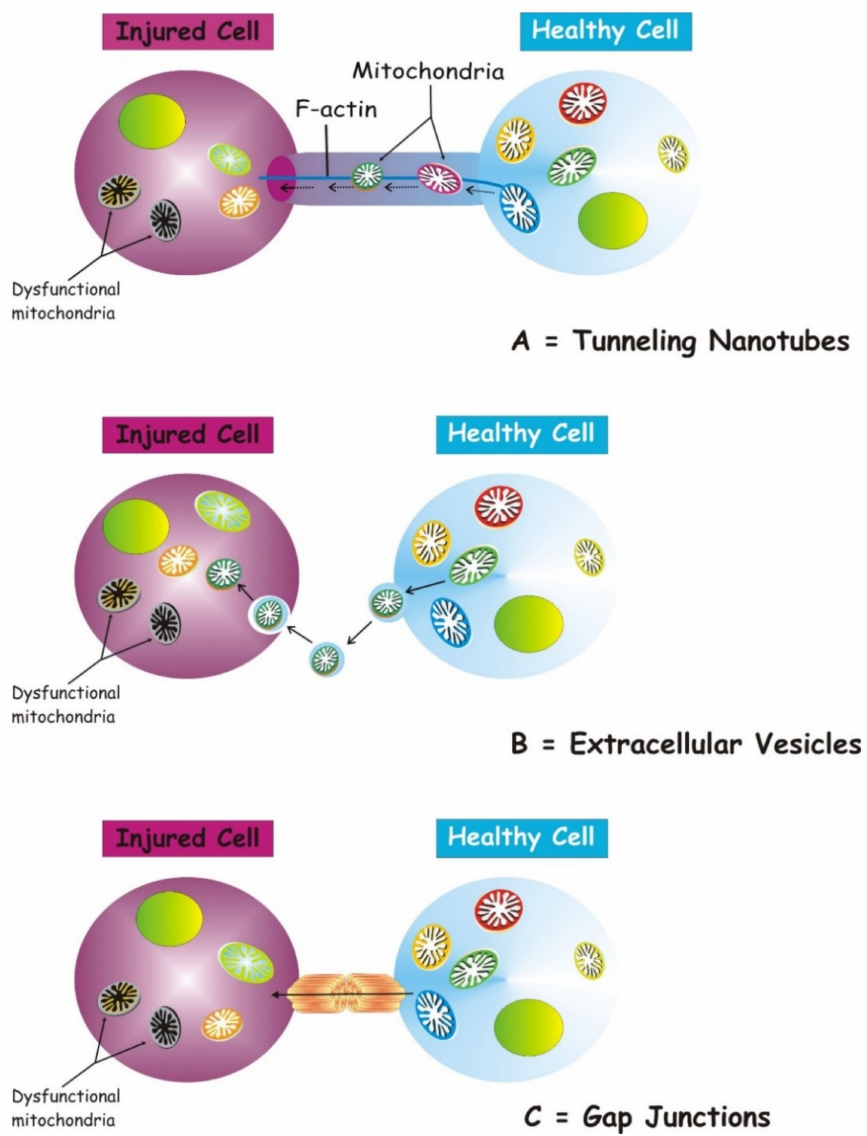
Figure 1. Three main forms of intercellular communication related to transcellular mitochondrial transfer. Under different injury signaling, three main forms of intercellular communication related to mitochondrial transcellular transfer can be formed: tunneling nanotubes ( A ), extracellular vesicles ( B ), and gap junctions. ( C ). For details see the